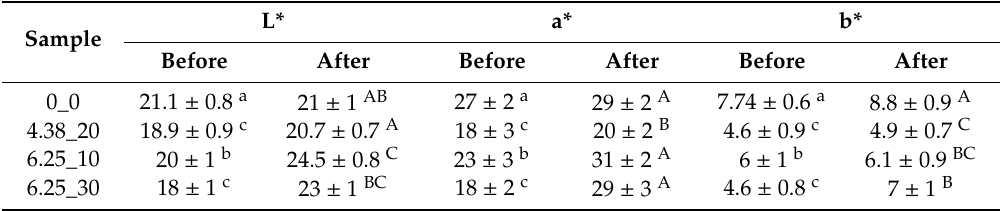
Table 2. Color parameters (L* = lightness, a* = red / green index, b* = yellow / blue index) of untreated and PEF-treated beetroot cylinders before and after extraction.